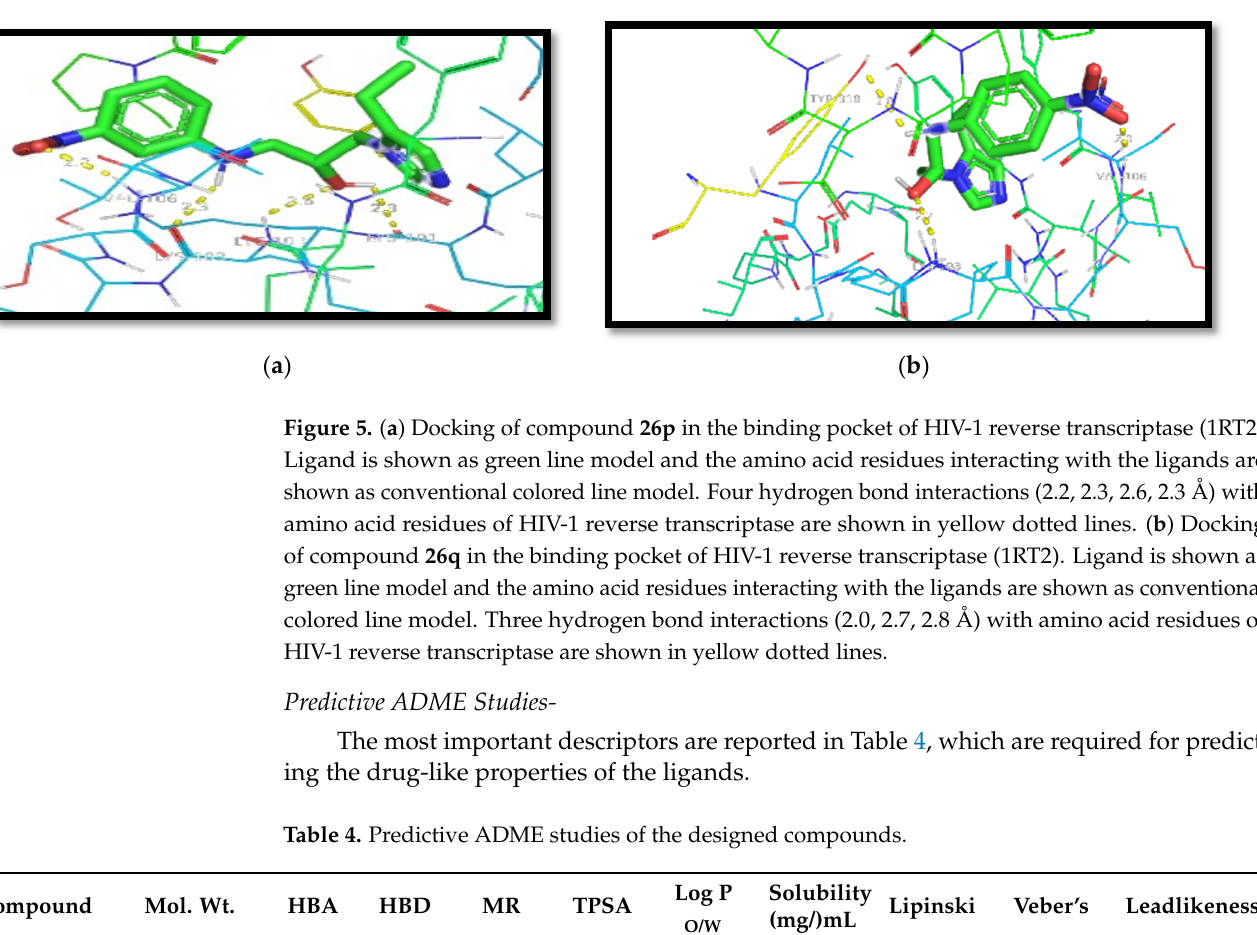
( b ) Figure 4. ( a ) Redocking of co-crystallized ligand TNK ( 29 ) in the binding pocket of HIV-1 reverse transcriptase (1RT2). Ligand is shown as pink line model and the amino acid residues interacting